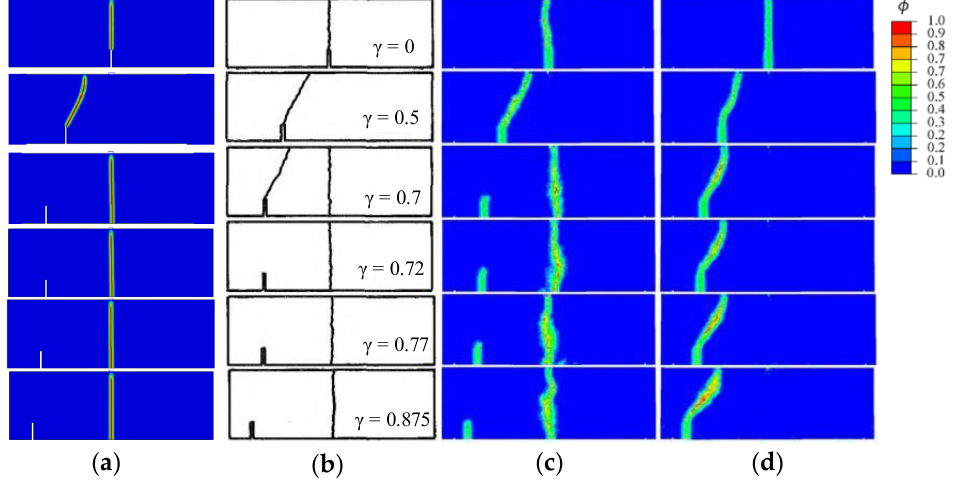
Figure 7. Ultimate damage profile of six specimens with the rising notch offset ( γ = 0, 0.5, 0.7, 0.72, 0.77 and 0.875 from top to bottom): ( a ) PF-CZM; ( b ) experimental results [53]; ( c ) intermediately homogenized peridynamic (IH-PD) model; ( d ) fully homogenized peridynamic (FH-PD) model [44].